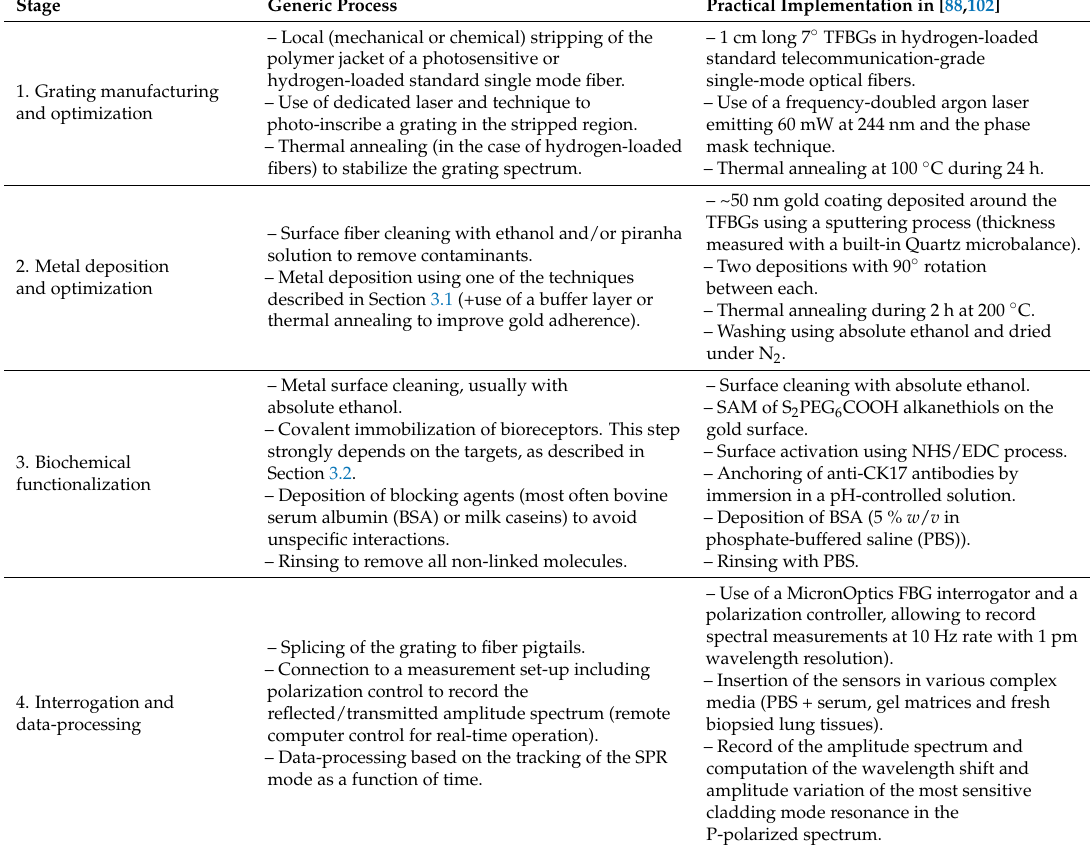
Main steps required to modify an optical-fiber section into a plasmonic fiber-grating